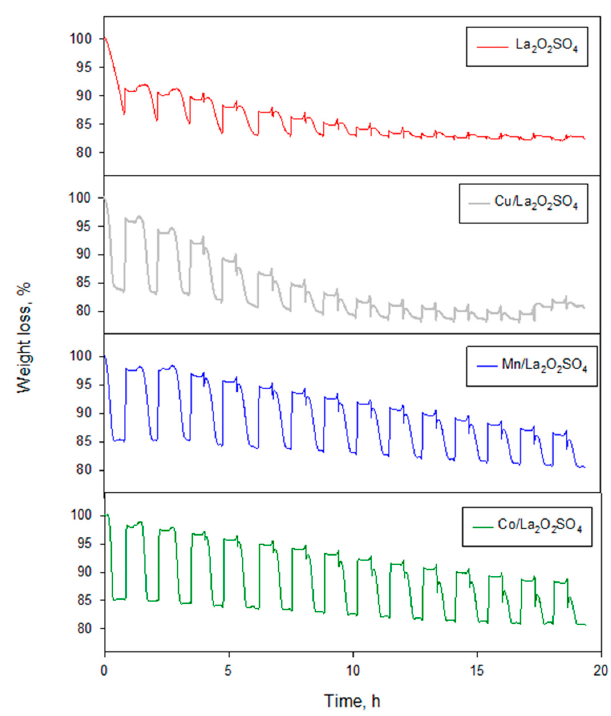
Figure 6. Reducing (under CH 4 )/oxidation cycles of La 2 O 2 SO 4 and metal (Cu, Mn, Co) promoted La 2 O 2 SO 4 carried out at 900°C (15